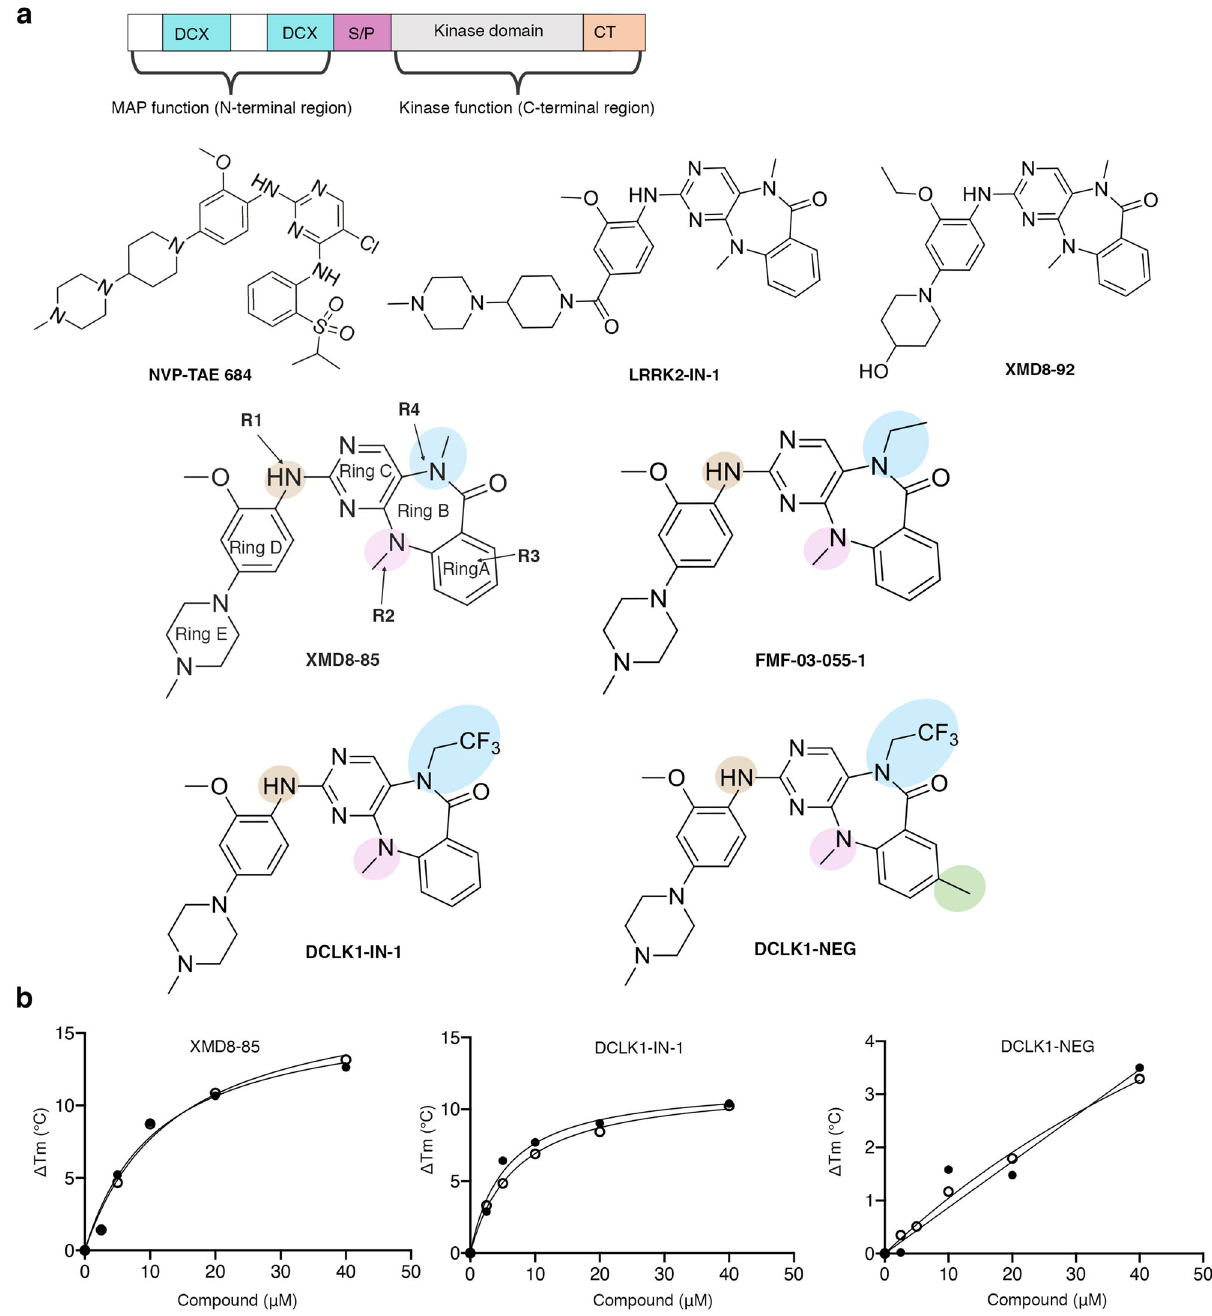
Fig. 1 Benzopyrimido-diazipinone scaffolds and their binding to DCLK1-KD. a DCLK1 domain architecture highlighting the DCX domains at the N-terminal region and the kinase domain with its C-terminal regulatory tail (CT) at the C-terminal region. The N-terminal and the C-terminal regions are connected by the serine/proline (S/P) rich linker. Chemical structures of NVP-TAE684 and benzopyrimido-diazipinone scaffolds. R1, R2, R3, and R4 positions previously described 28 are labelled and coloured. b Change in melting temperature ( Δ T m ) of DCLK1-KD as a function of the concentration of XMD8-85, DCLK1-IN-1 and DCLK1-NEG. Change in the Δ T m was calculated from the melting pro fi les shown in Supplementary Fig. 1. Each data point represents the calculated Δ T m calculated for each inhibitor concentration; shown in duplicate experiments are